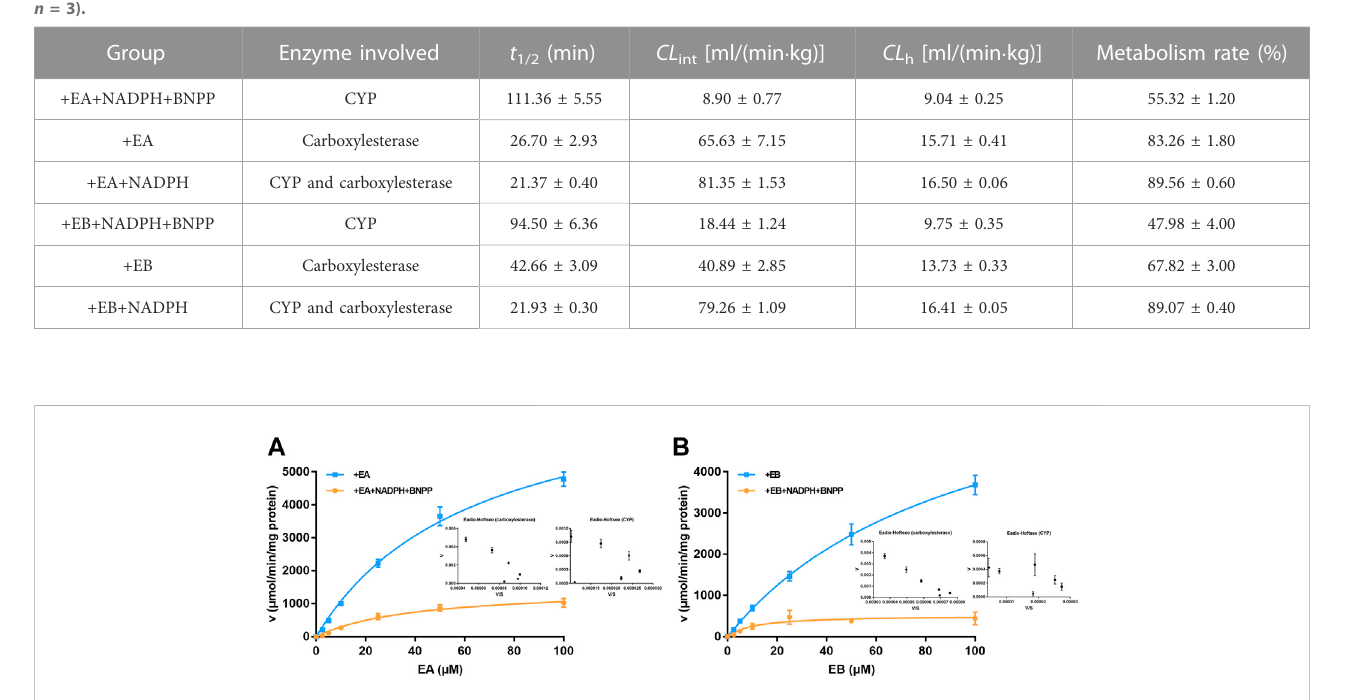
FIGURE 6 Michaelis – Menten curves of EA (A) and EB (B) in HLMs metabolized by carboxylesterase or CYP and their corresponding Eadie-Hofstee plots (as insert) (mean ± SD; n = 3).